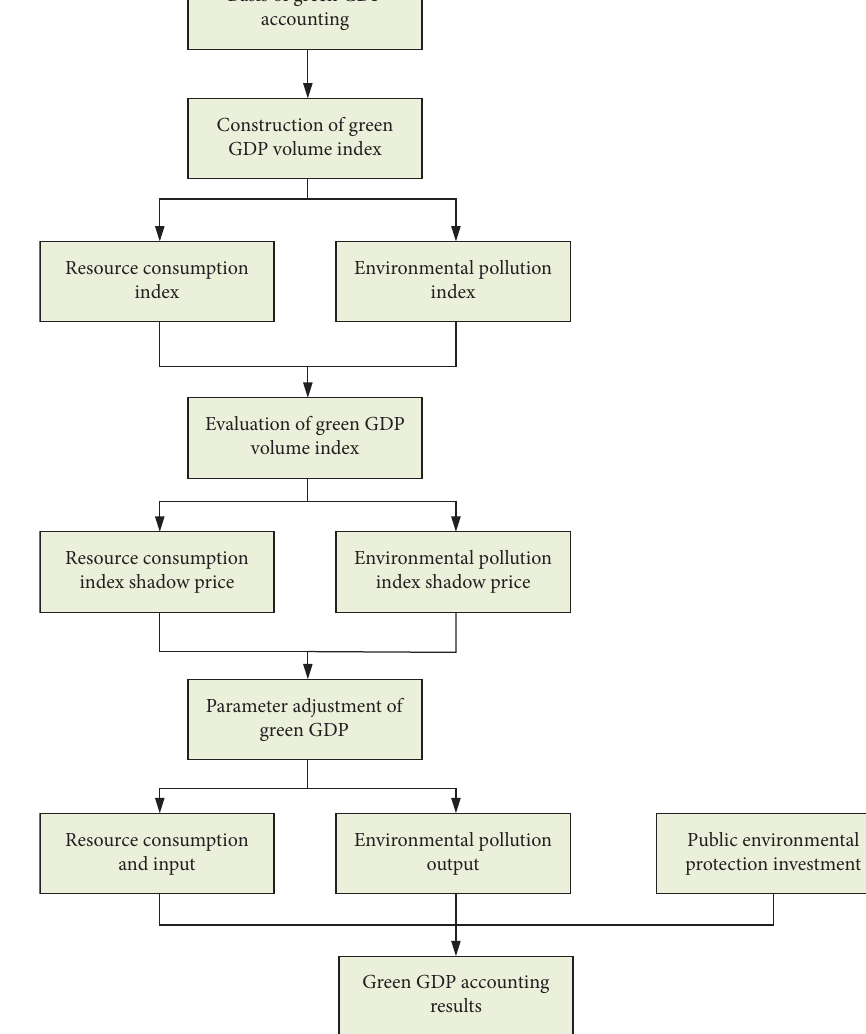
Figure 2: Green GDP accounting system model. Table 1: Classification method of resource and environmental value.